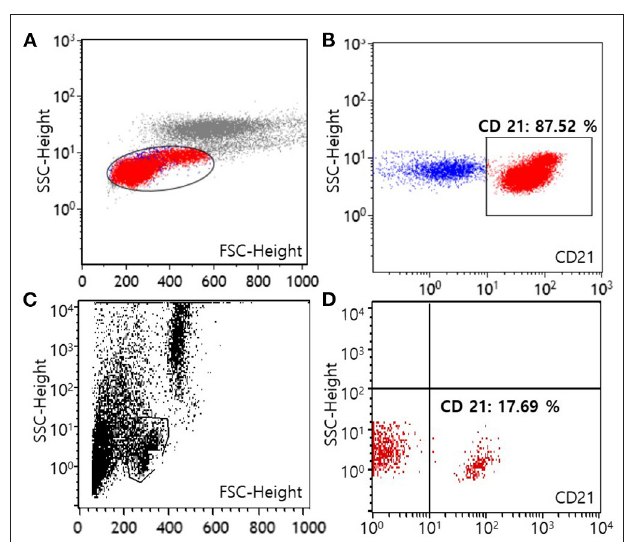
FIGURE 2 | Flow cytometric scatter plots of peripheral blood from a dog with B-cell chronic lymphocytic leukemia at the time of diagnosis (A,B) and after 1 year of multimodality therapy (C,D) . A template is used to identify lymphocytes (A,C) . On the first visit, lymphocytes predominantly express the CD21 molecule (87.52% among lymphocytes), showing a B-cell origin (B) . After 1 year of treatment, the number of lymphocytes expressing the CD21 molecule has decreased to normal [17.69% among lymphocytes, (D) ] (FSC, forward scatter; SSC, side